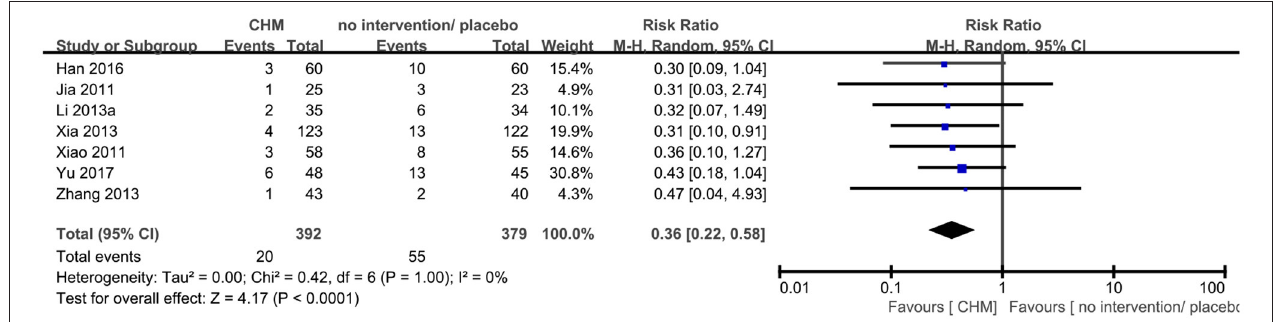
FIGURE 4 | Forest plot of comparison: CHM vs. no intervention/placebo, outcome: number of participants progressed to dementia.